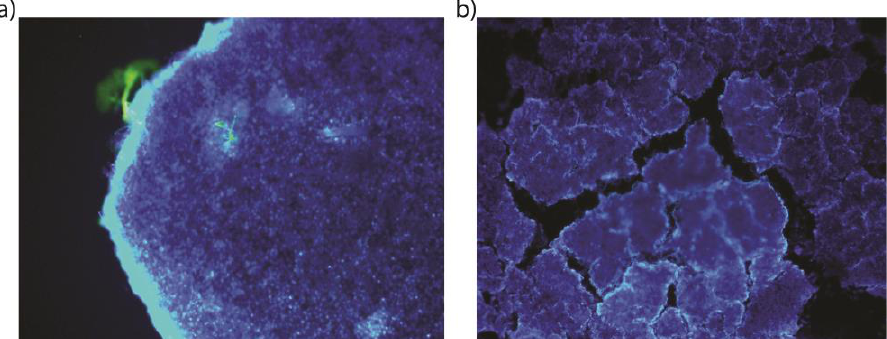
Figure 8. Three-dimensional fluorescence microscope images of ( a ) PC-3 cells (10× objective magnification, green filter) and ( b ) LNCaP cells (10× objective magnification, blue filter). The image of the nanoconjugates applied to the PC-3 cell line in the green filter can be seen. While cell nuclei are seen with DAPI, the intensely glowing region on the cell wall is thought to be the fluorescence feature from our nanoconjugates.